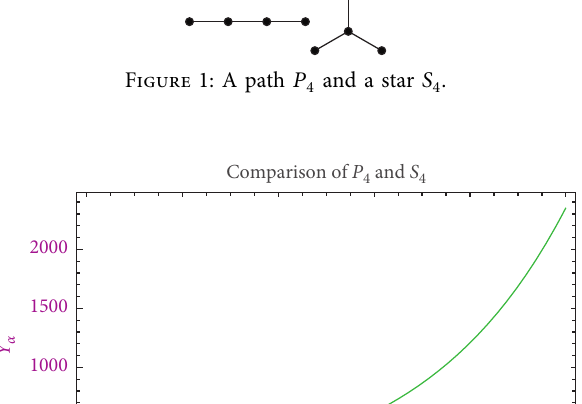
Figure 1: A path P